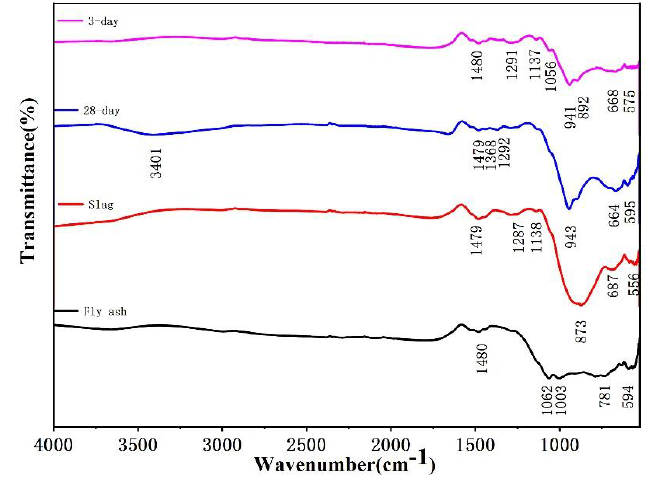
Figure 11. Infrared spectrum of slag, fly ash, and optimum mix proportion test specimens at different ages.